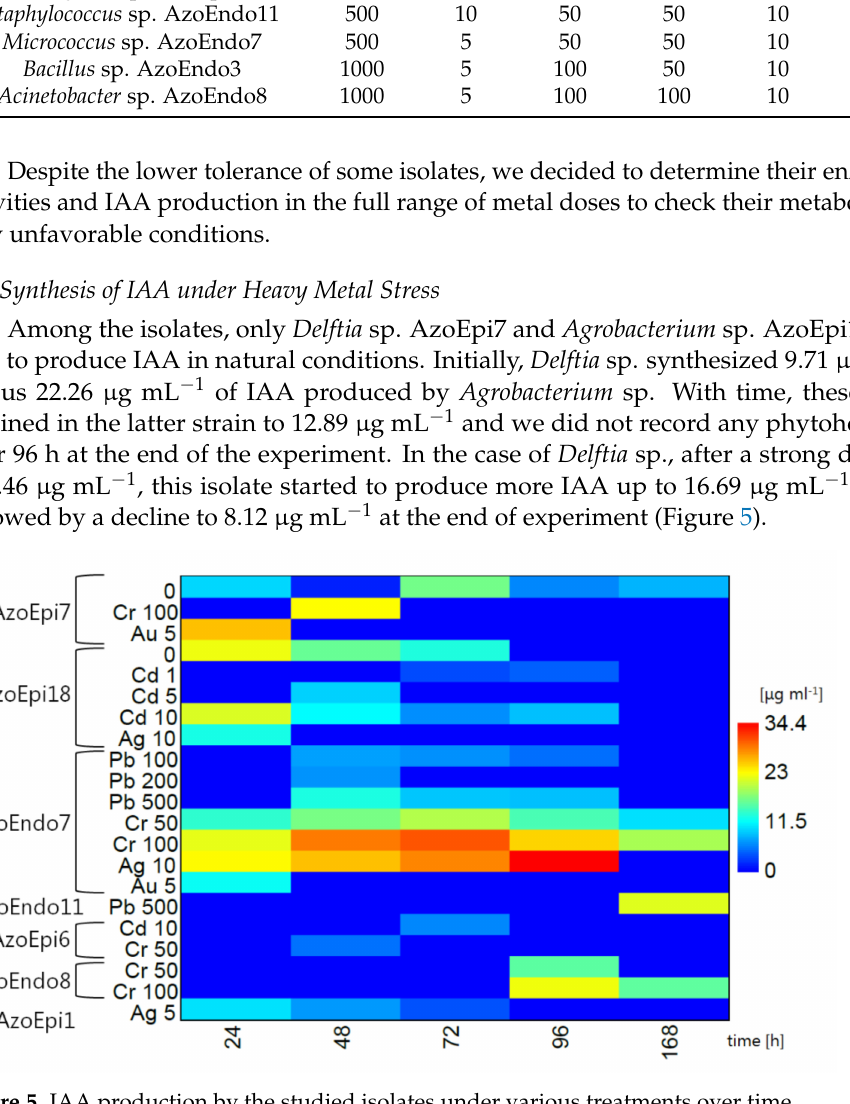
Figure 5. IAA production by the studied isolates under various treatments over